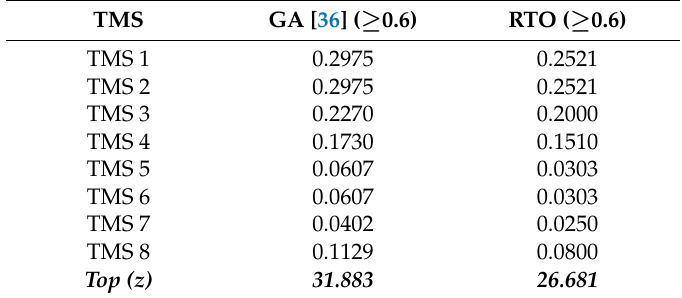
Table 3. Optimal TMS for Case 1.